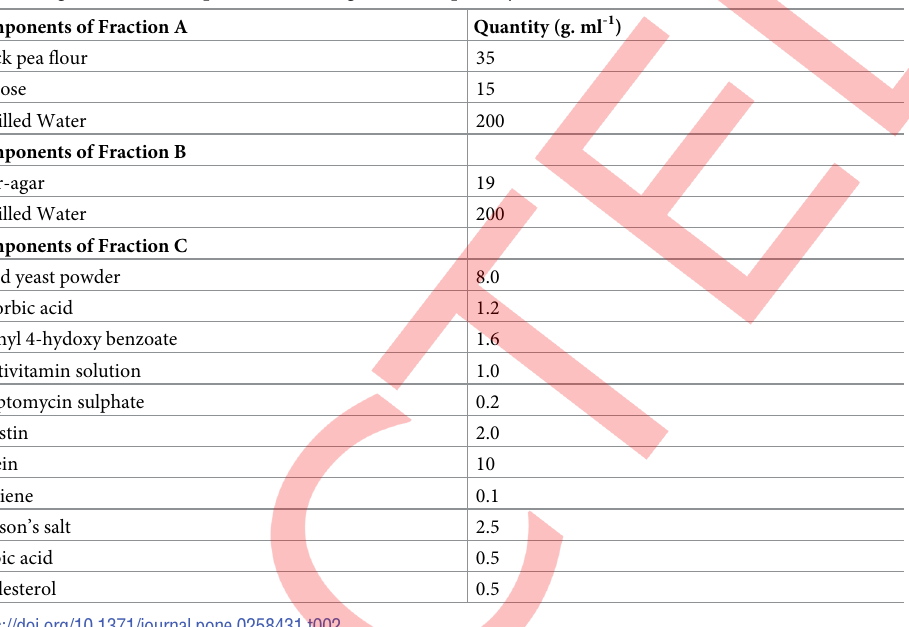
Table 2. Ingredients of chickpea medium along with their